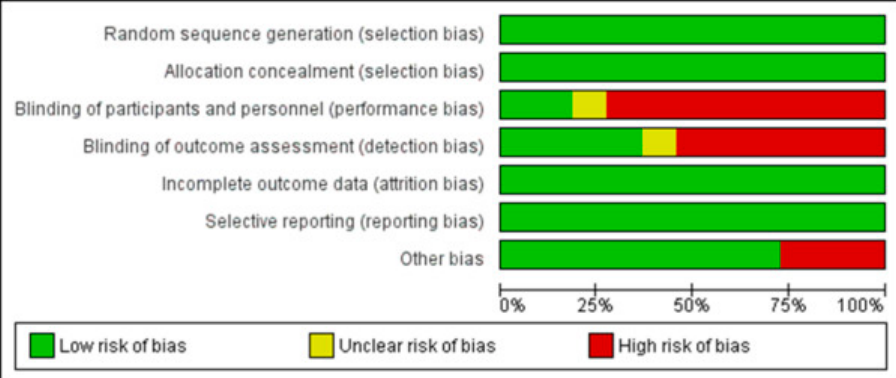
Figure 2. Risk of biases of included studies, overall analysis.